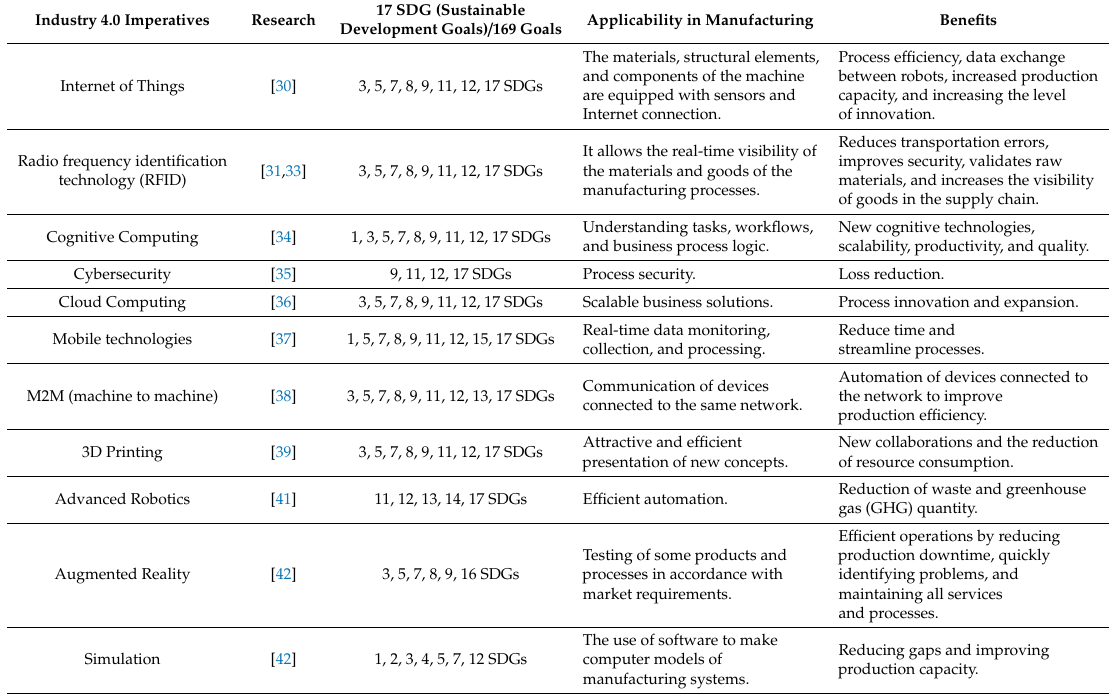
Table 4. Sustainable development and Industry